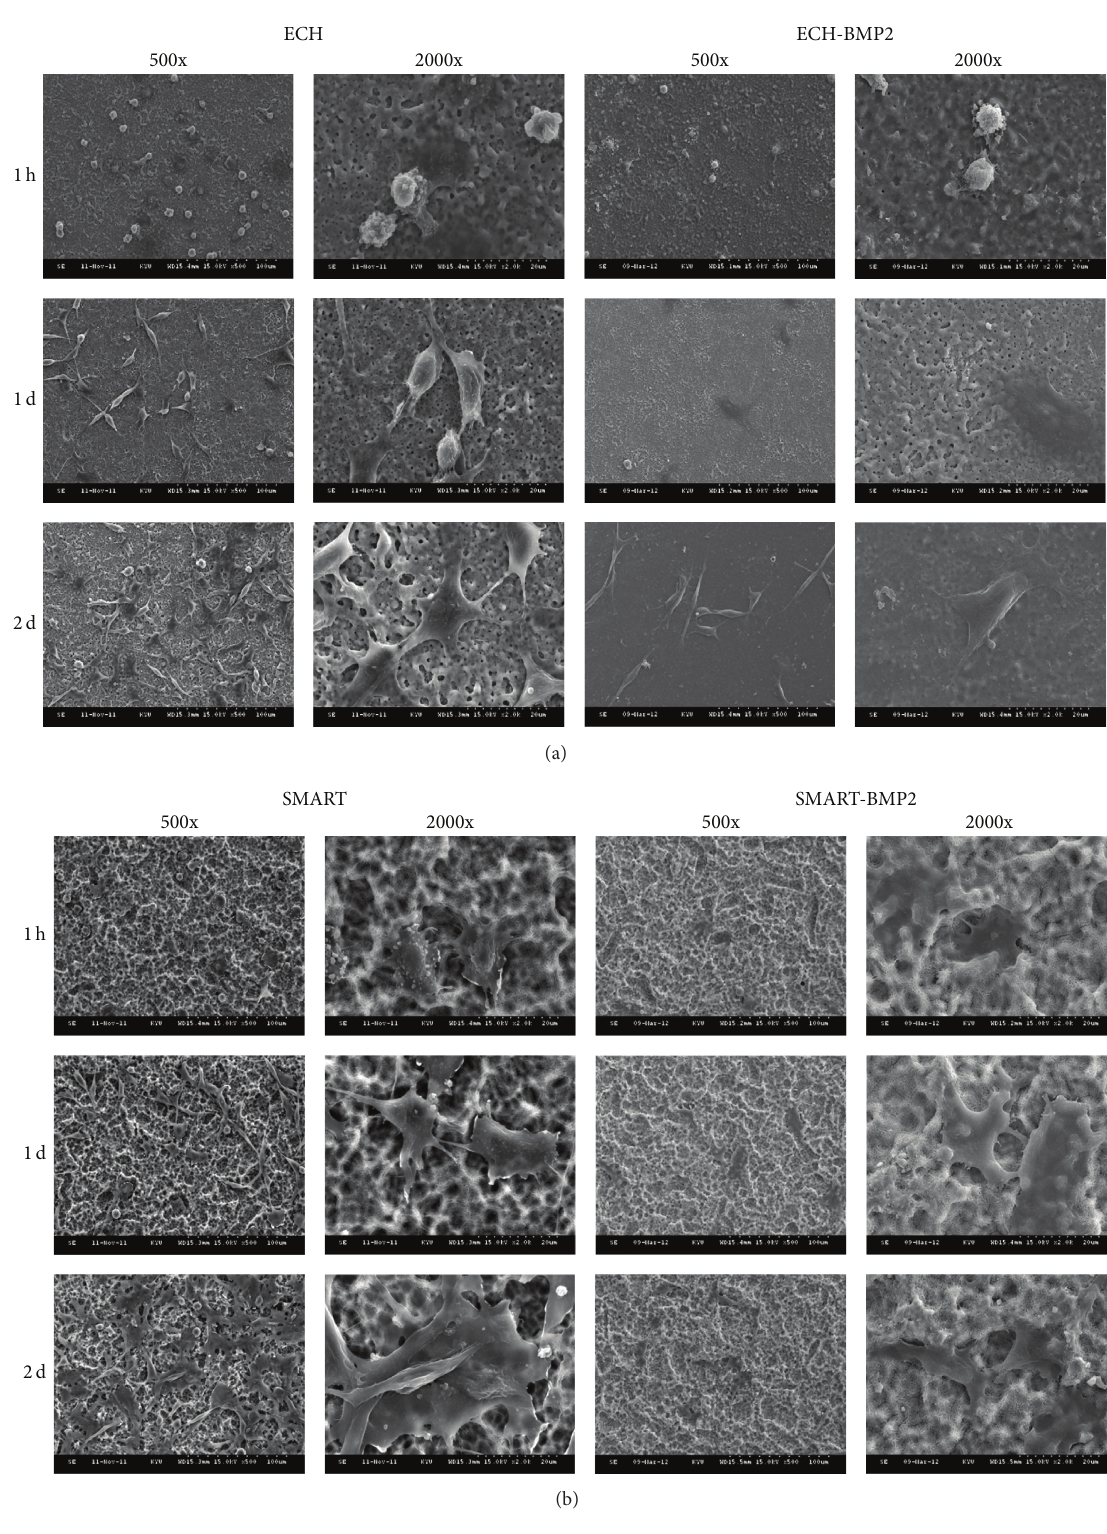
Figure 2: Cell morphology on various Ti surfaces. Micrograph images were observed using SEM of D1 cells on ECH (a) and SMART (b) surfaces coated with or without BMP-2 after 1 h, 1d, and 2 d (ECH-B: ECH-BMP-2; SMART-B: